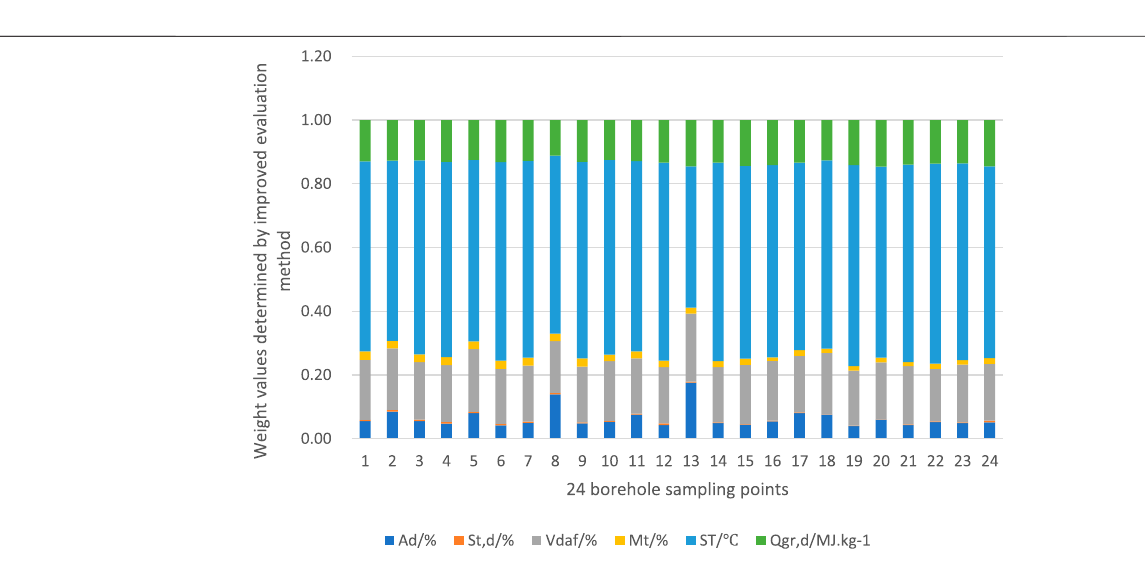
FIGURE 7 | Weight values determined by the improved evaluation